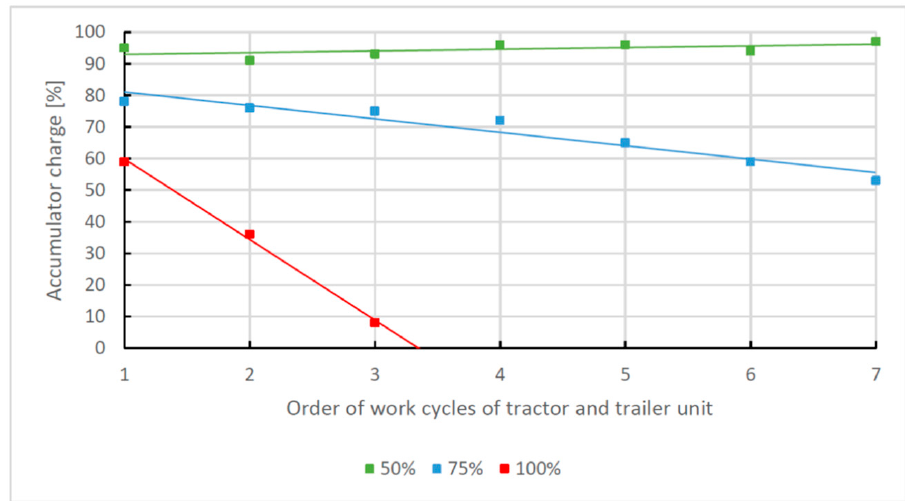
Figure 9. Level of the battery charge relative to the number of working cycles of the tractor-trailer unit (1–7) and the setting of the potentiometer controlling the power input of the trailer hybrid drive (50, 75 and 100%). Forwarding distance of 500 m (author: Tomáš Zemánek).